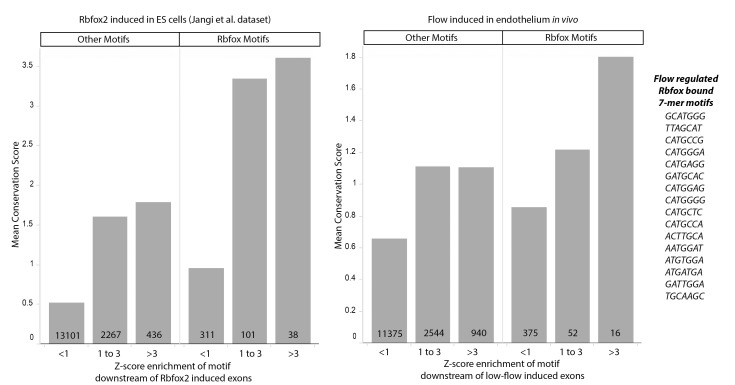
Conservation of Rbfox2 motifs enriched near flow-regulated skipped exons.Plot showing the average conservation score (y-axis) and z-score (x-axis) for individual motifs near induced skipped exons in the published positive-control set (Rbfox2 regulated, Jangi et al. Genes and Development 2015) and the flow-induced set of skipped exon described here. Rbfox Motifs and Other Motifs are defined by Rbfox2 binding in vitro in the CisBP-RNA database (z-score >1 in CisBP-RNA). Mean conservation score on the Y-axis is derived from PhyloP vertebrate score at for each nucleotide in the given 7-mer motif adjacent to the regulated skipped exons. Z-score enrichment on the X-axis bins motifs into strongly (z-score >3), moderately (z-score 1 to 3) and weakly (z-score <1) enriched in the downstream region (5’ss) of induced skipped exons, relative to background sets of unregulated skipped exons. Number of motifs in each column are shown at the bottom of the bar. Motifs are shown for the far-right column of flow-induced (Rbfox2 motif z-score >1 in CisBP-RNA, and z-score enrichment >3 downstream of flow induced skipped exons).